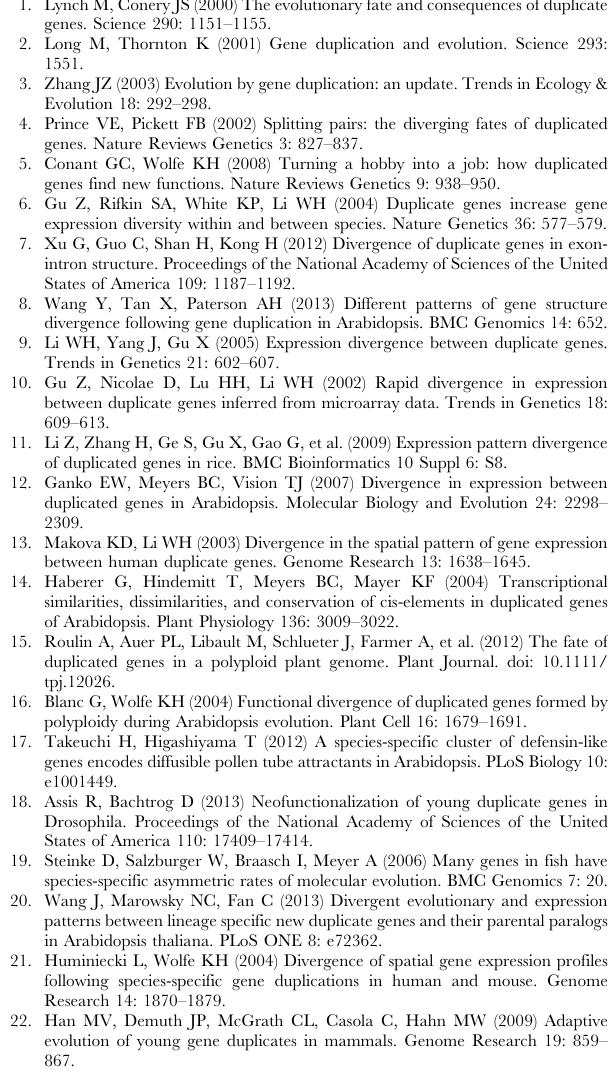
Figure S3 The relationship between Pearson’s correla- tion coefficient of gene expression and structural divergence when the analysis was restricted to pairs of genes that were expressed in three or more tissues. Table S1 Details of sequencing libraries. (XLSX) Table S2 Complete list of duplicated gene pairs. (XLSX) Table S3 GO enrichment analysis of Cattle-specific duplicate genes.